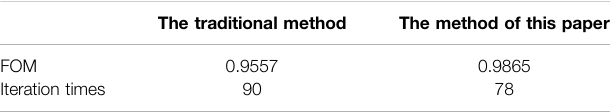
TABLE 2 | Comparison of the indexes of two kinds of memristive bridge synaptic neural networks. The traditional